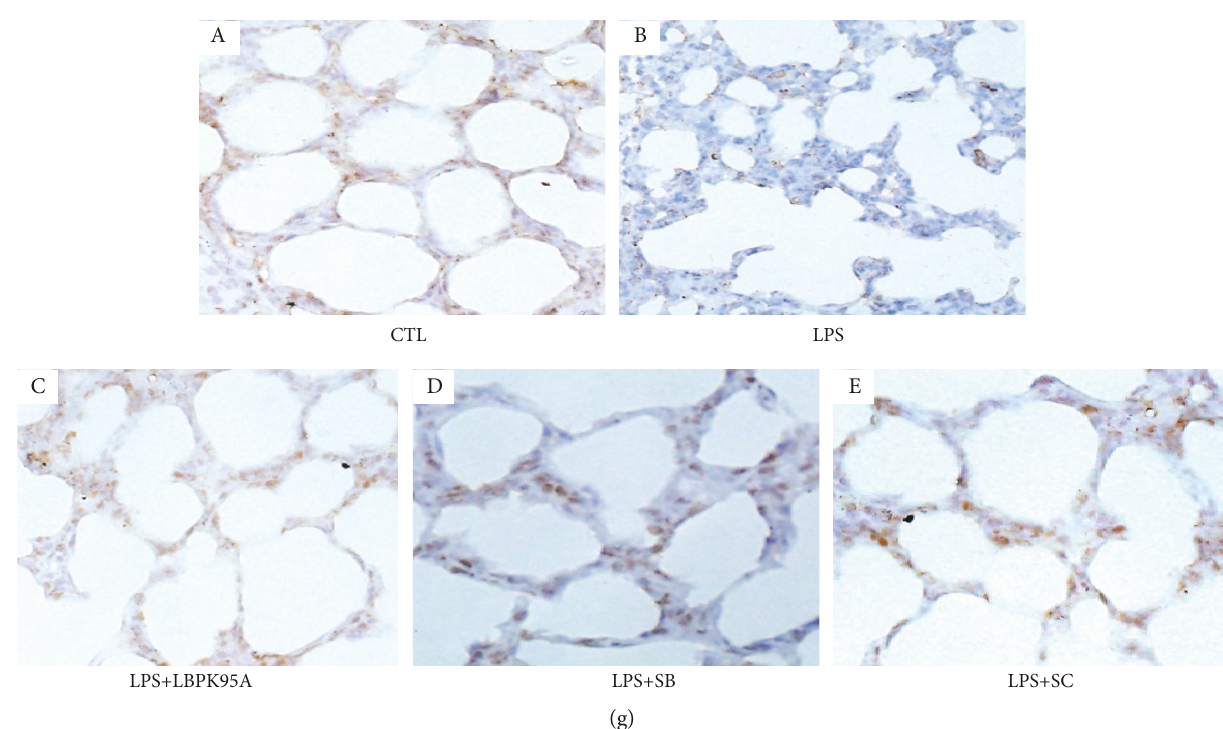
Figure 7: Expression of LBP and FKN protein in lung tissue homogenates and in serum of the ARDS rat model. The LBP and FKN expression in lung tissue homogenates and sera of rats with ARDS was determined by ELISA and western blotting. The results demonstrate that (a) LPS increased the levels of LBP expression signi fi cantly in both cases ( p < 0 05 in all cases). The LBP levels of the LPS+LBPK95A group were upregulated compared with those of the control group and downregulated compared with those of the LPS group ( p < 0 05 in all cases) ((a), (b), and (c)). (b) LPS reduced the levels of FKN expression in both cases ( p < 0 05 in all cases). The FKN levels of the LPS+SB and LPS+SC groups are downregulated compared with those of the control group and upregulated compared with those of the LPS group ( p < 0 05 in all cases) ((d), (e), and (f)). The FKN levels of the LPS+SB and LPS+SC groups are lower than those of the LPS+LBPK95A group ( p < 0 05 in all cases) ((d), (e), and (f)). ∗ represents p < 0 05 when compared with that in the CTL group rats; # represents p < 0 05 when compared with that in the LPS group rats. △ represents p < 0 05 when compared with that in the LPS+LBPK95A rats. Immunohistochemical staining was used to determine the localization of FKN in the rat lungs. As can be seen, the major sites of FKN expression are in alveolar type I and type II epithelia. The expression of FKN protein was compared between the di ff erent groups of rats. The staining intensity and number of cells expression of FKN decreased markedly in the LPS group, when compared to those of the control group. The use of LBPK95A, SB203580, and SC-514 partly reduced the reduction of FKN seen (g). The photomicrographs are at 400x magni fi